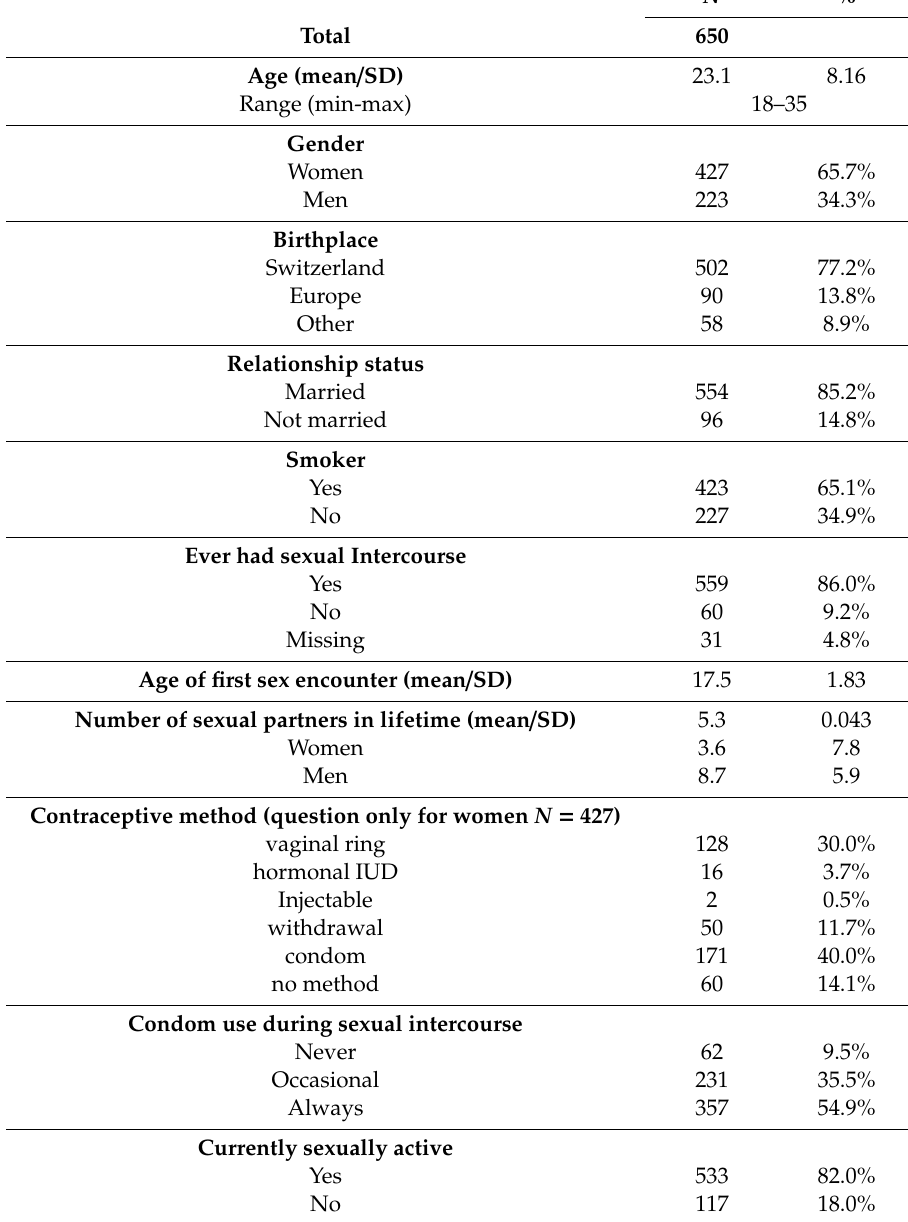
Table 1. Socio-demographic characteristics of the study